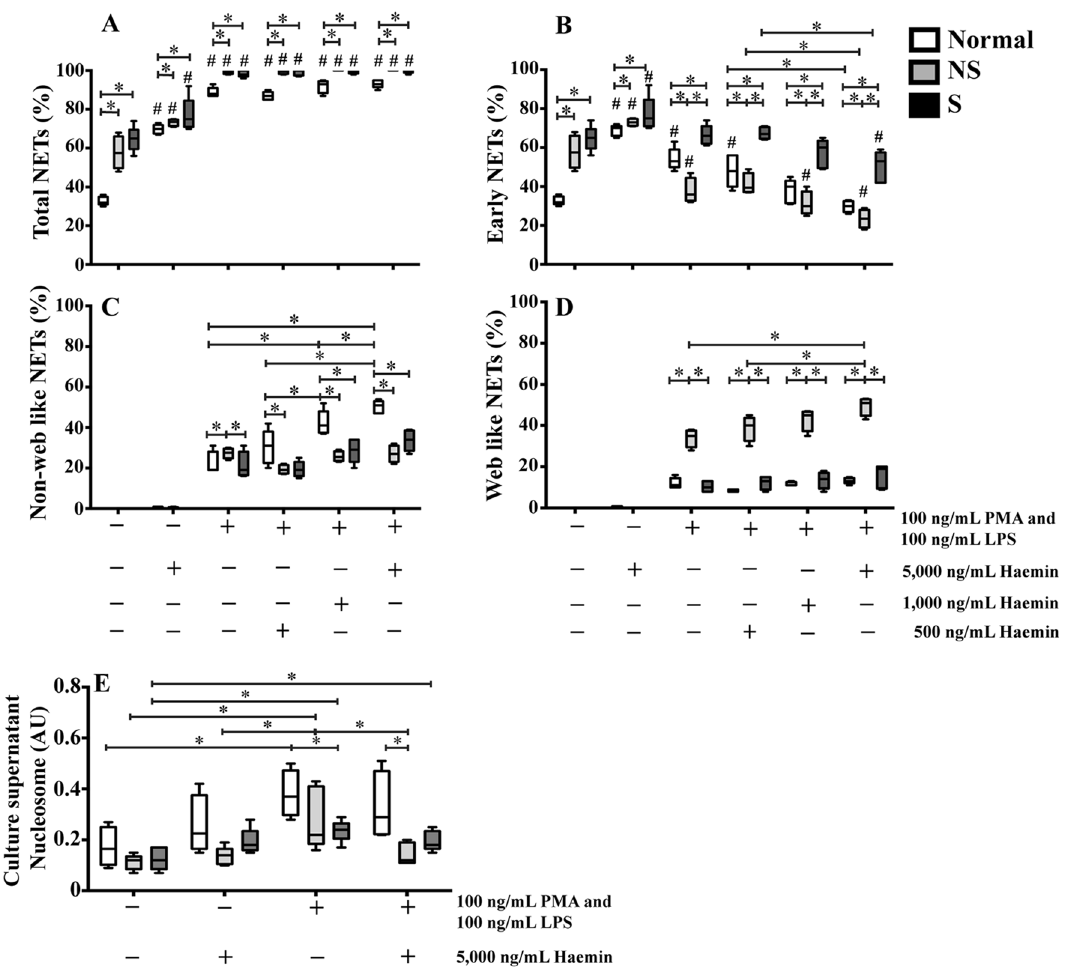
Figure 3. Iron overload and infection induced NET formation in β-thalassaemia/HbE patients. Isolated neutrophils from 5 normal subjects (Normal), 5 non-splenectomised β-thalassaemia/HbE patients (NS) and 5 splenectomised β-thalassaemia/HbE patients (S) were treated with either PMA and LPS or haemin or combined stimuli for 90 min at 37 °C, 5% CO 2 , then, neutrophils were fixed and stained with fluorochrome conjugated antibodies specific to neutrophil elastase (NE), histone H2A and DAPI to captured with Z-stack mode by using an Olympus confocal laser scanning microscope FV10i-DOC (Olympus Corporation, Tokyo, Japan) equipped with Olympus FluoView software. Experiments were performed as duplicated. One hundred neutrophils per condition were counted at 60 × oil lens and the percentages of ( A ) total NET formation of neutrophils, ( B ) early phase, ( C ) late phase with non-web like and ( D ) late phase with web-like structures were determined. (Supplementary Figs. 2–4) ( E ) Cell-free supernatant samples were collected after incubation to determine nucleosomes (cell death detection ELISA PLUS kit, Roche Diagnostics GmbH). *Significant difference when compared between groups at P < 0.05. # Significant difference when compared with unstimulated neutrophils from the individual groups at P < 0.05. Statistical analysis was performed by using a non-parametric Mann– Whitney U Test. DAPI; 4 ′ , 6-diamidino-2-phenylindole, The effect of iron overload on neutrophil responsiveness to infection in β-thalassaemia/HbE was then exam- ined by co-incubating neutrophils with haemin and PMA/LPS. Early NETs were significant decreased and non- web-like late NETs were significantly increased in neutrophils from normal subjects and splenectomised patients treated with haemin/PMA/LPS in a haemin dose-dependent manner. Nevertheless, splenectomised patients’ neutrophils had a reduced degree of early NETs, and increased non-web-like late NETs as compared to normal subjects, while the web-like late NETs were not significantly different between PMA/LPS-treated and haemin/ PMA/LPS-treated neutrophils of both groups (Fig. 3B–D). By contrast, neutrophils from non-splenectomised patients had significantly more web-like late NETs than non-web-like NETs after haemin/PMA/LPS-treatment. At the highest doses of haemin/PMA/LPS treatment, early NETs in neutrophils from splenectomised patients (50 ± 4/53 ± 16%) were significant higher than in non-splenectomised patient neutrophils (24 ± 2/24 ± 9%) and in neutrophils from normal subjects (30 ± 1/30 ± 6%). In contrast, the majority of NETs in neutrophils from normal and non-splenectomised patients were non-web-like late NETs (50 ± 1/51 ± 6%) and web-like late NETs (50 ± 2/51 ± 8%), respectively (Fig. 3B–D). The decreased late NETs in neutrophils from splenectomised patients could imply neutrophil dysfunction in response to infection.